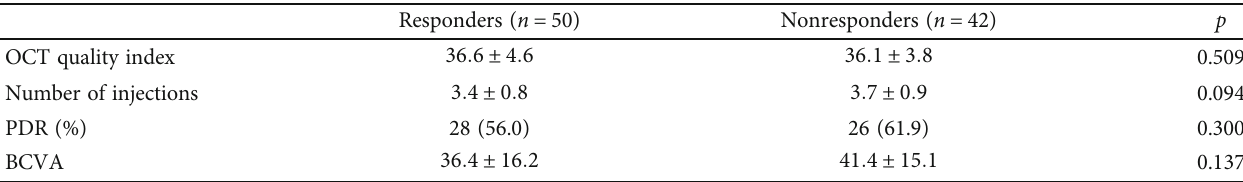
Table 1: Baseline ocular characteristic comparison between responders and nonresponders by a generalized estimating equation model with adjusting for correlation between two eyes within the same patient ( N = 92